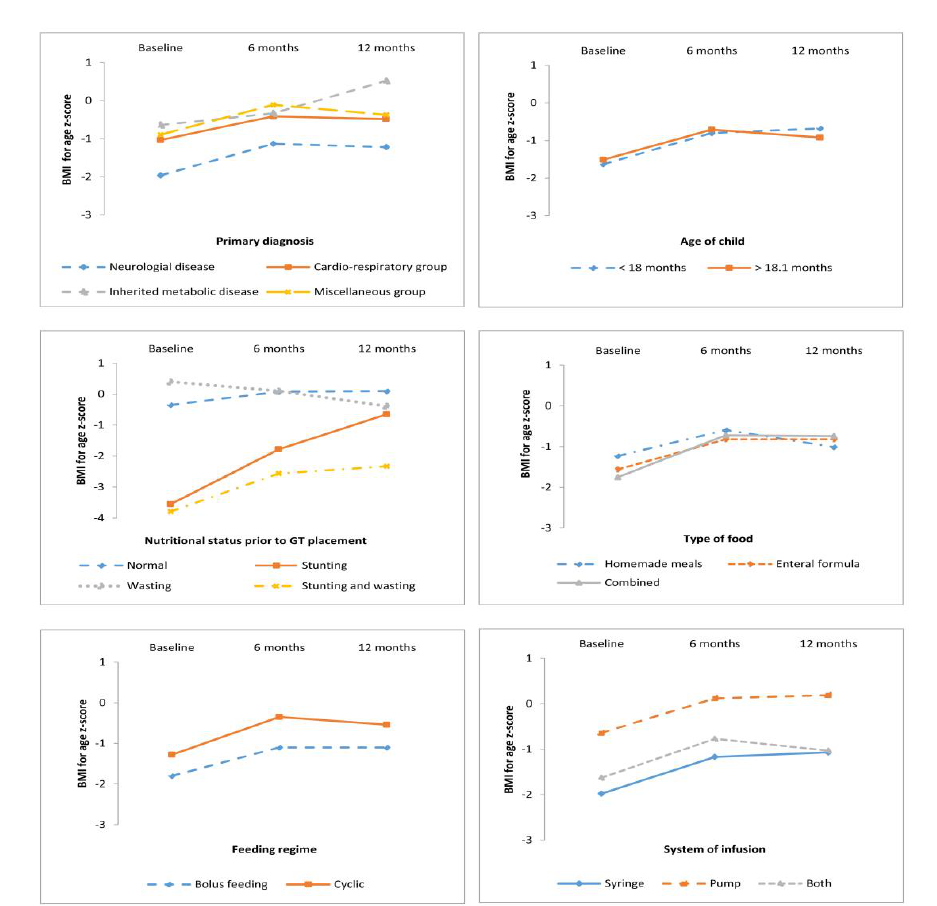
Figure 1. BMI-for-age z-score according to analyzed variables.